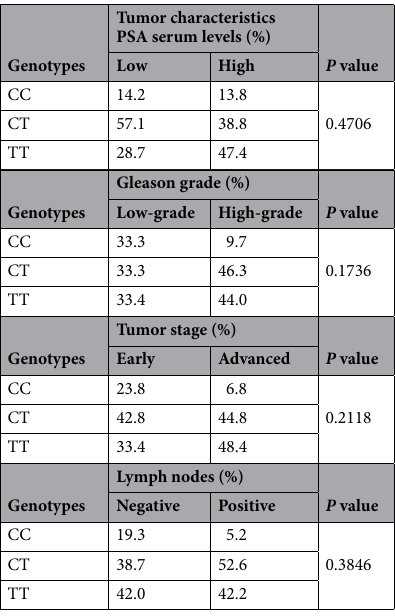
Table 3. Association between rs4054823 genotypes and clinicopathological characteristics. Significant difference at P < 0.05.